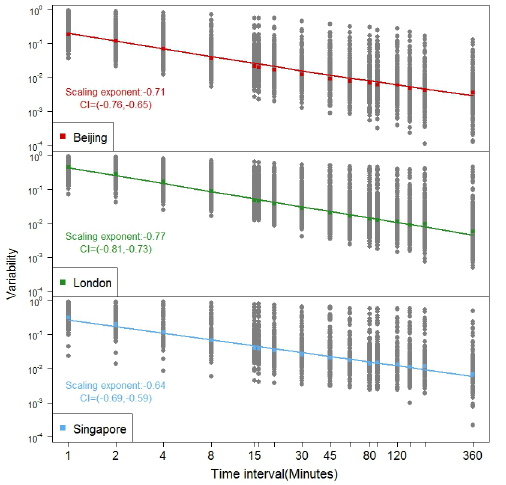
Fig 2. Variability as a function of the time intervals for London, Singapore, and Beijing. Note: The negative linear relations show that the variability declines with increasing temporal scale but the variations in the variability (the variance of the covariance) which relate to the stations also increase for all three